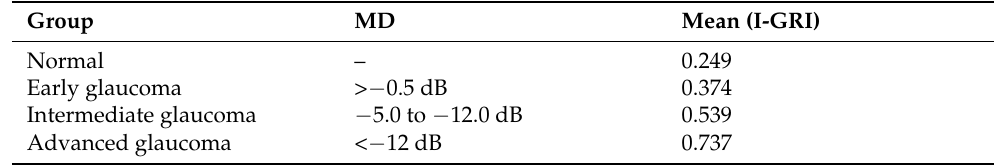
Table 12. Three stages of glaucoma progression and their range of MD. Group